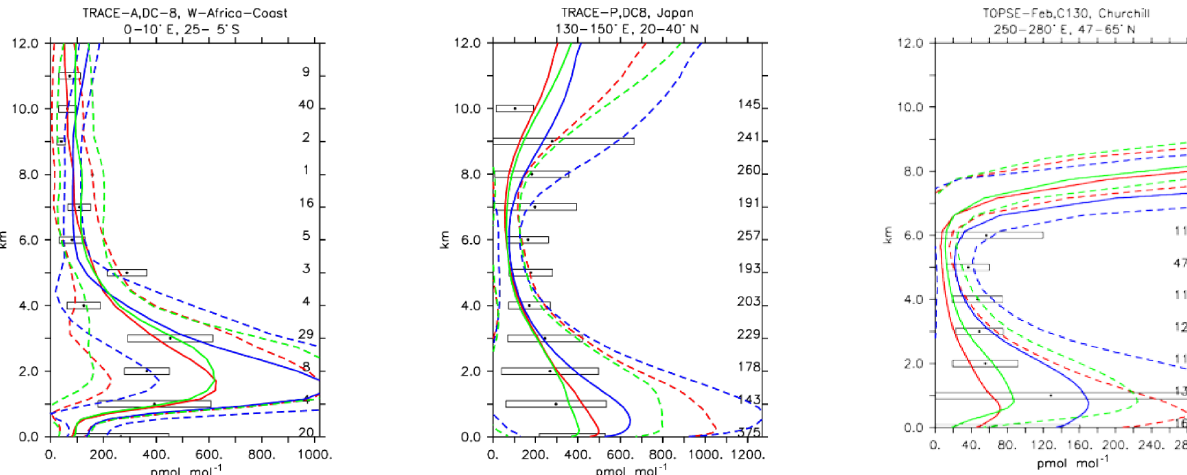
Figure 20. Comparison of simulated HNO 3 vertical profiles by using the CBA (red), MOC (blue) and MOZ (green) chemistry versions against aircraft data (black). Line styles and symbols have the same meaning as in Fig. 12.